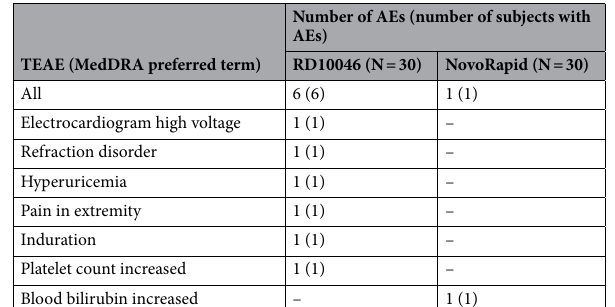
TEAE (MedDRA preferred